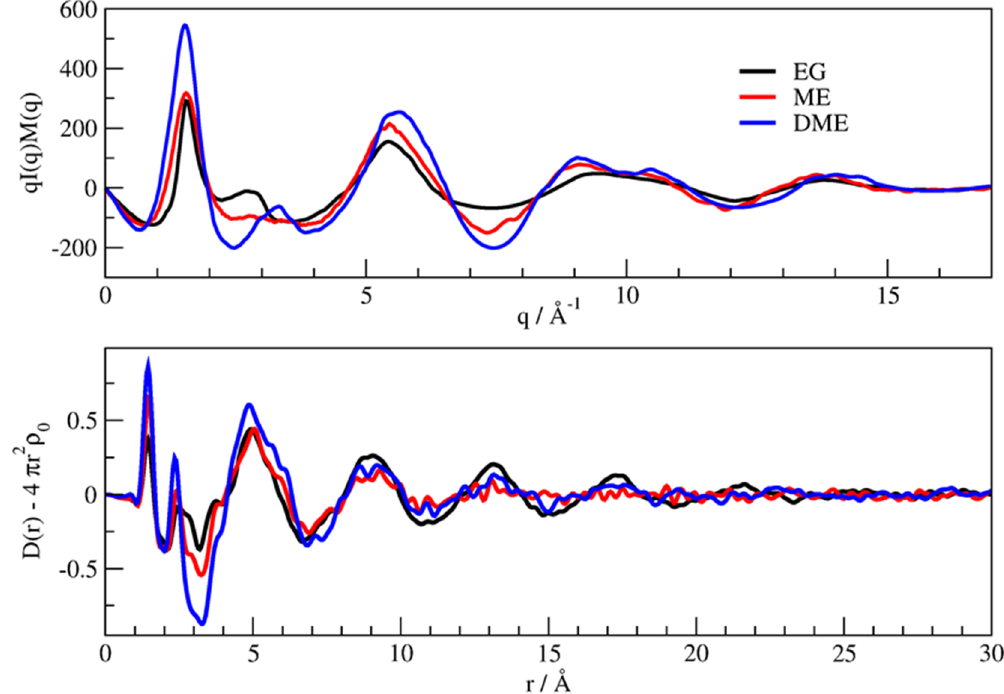
Figure 1. X-ray structure factors (top panel) and total radial distribution functions (bottom panel) of the liquids. Ethylene glycol (EG): black; methylcellosolve (ME): red; 1,2-dimethoxyethane (DME): blue.